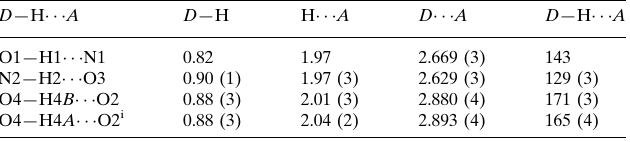
Hydrogen-bond geometry (A˚ , (cid:2)